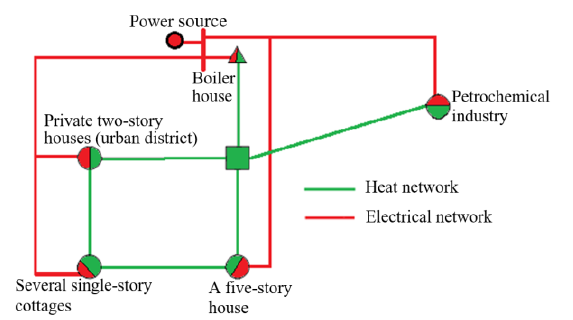
Fig. 1. Integrated energy system test scheme.